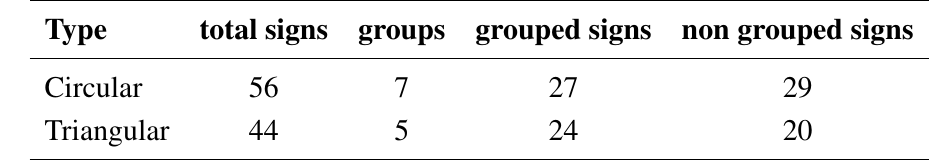
Table 1. Signs and groups